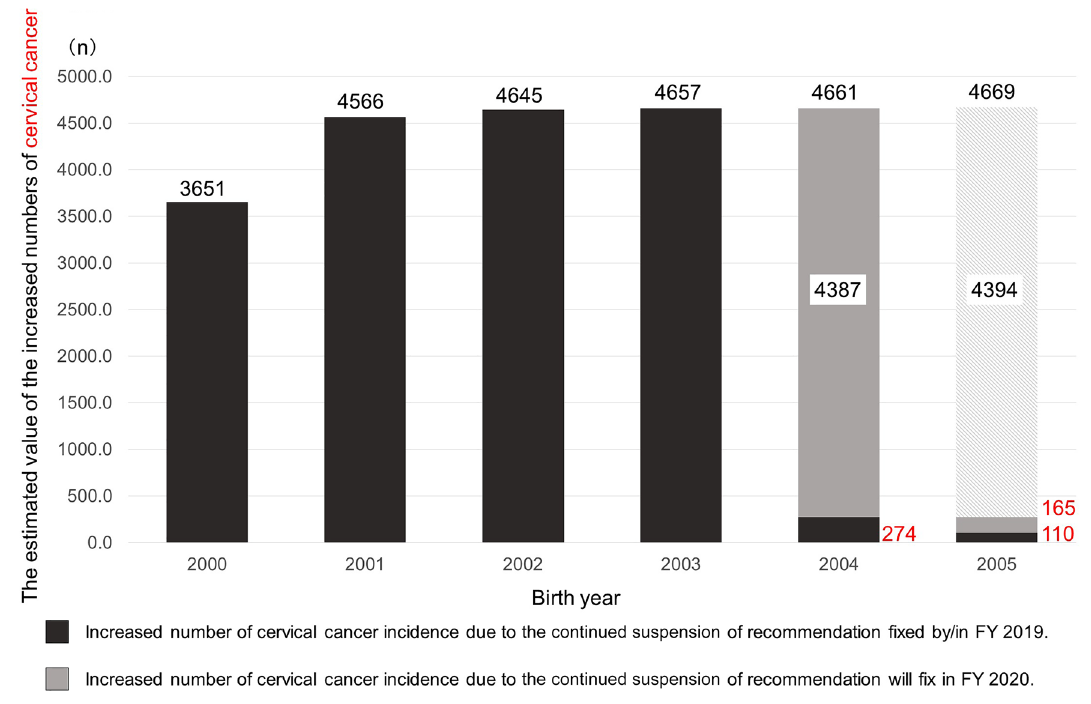
Figure 2. The estimated increased numbers of cervical cancer patients. As an example, the estimated increased numbers of cervical cancer patients fixed in FY2019 among those born in FY2003 was calculated as follows: 1. Relative risk of cervical cancer among females born in FY2003—if the governmental recommendation restarted in FY2019 = (Rate of cervical cancer that cannot be prevented with HPV vaccine) + (Rate of cervical cancer that can be prevented with HPV vaccine) × (Rate of girls unprotected by HPV vaccine who were born in FY2003)/(Rate of girls unprotected by HPV vaccine who were born in FY1993. 2. Rate of girls unprotected by HPV vaccine who were born in FY2003 = ( Non-inoculation rate at 13 years old) × (sexual experience rate at 13 years old) + (non-inoculation rate at 14 years old ) × (new sexual experience rate at 14 years old) + (non-inoculation rate at 15 years old) × (New sexual experience rate at 15 years old) + (Non- inoculation rate at 16 years old) × (New sexual experience rate at 16 years old) + (Non-inoculation rate during lifetime) × (New sexual experience rate during lifetime). 3. Rate of girls unprotected by HPV vaccine who were born in FY1993 = (Lifetime non-inoculation rate) × (Lifetime sexual experience rate). 1, 2, and 3. The rate = 0.4 + 0.6 × ((1–0.0012) × 0.01 + (1–0.0019) × (0.02–0.01) + (1–0.0019) × (0.05–0.02) + (1–0.6893) × (0.84– 0.15)) / 1 × 0.85 = 0.6107. 4. Relative risk of cervical cancer to be fixed in place if the governmental recommendation is not resumed in FY2019 = (Relative risk of cervical cancer among those born in FY2003—if the governmental recommendation is resumed in FY2020, as calculated in the same way as 1, 2 and 3)— (Relative risk of cervical cancer among those born in FY2003—if the governmental recommendation is resumed in FY2019). The rate = 0.9998–0.6107 = 0.3881. 5. Number of females with cervical cancer fixed in place in FY2019 among females born in FY2003 = (Relative risk of cervical cancer to be fixed if the governmental recommendation is not resumed in FY2019) × (Nationwide cervical cancer cases estimated from the Regional cancer registry). The number = 0.3881 × 11,293 = 4383. Similarly, that fixed in place of FY2018 among those born in FY2003 was estimated to be 274, and the increased number for the females born in FY2003 was calculated to be 4657 in